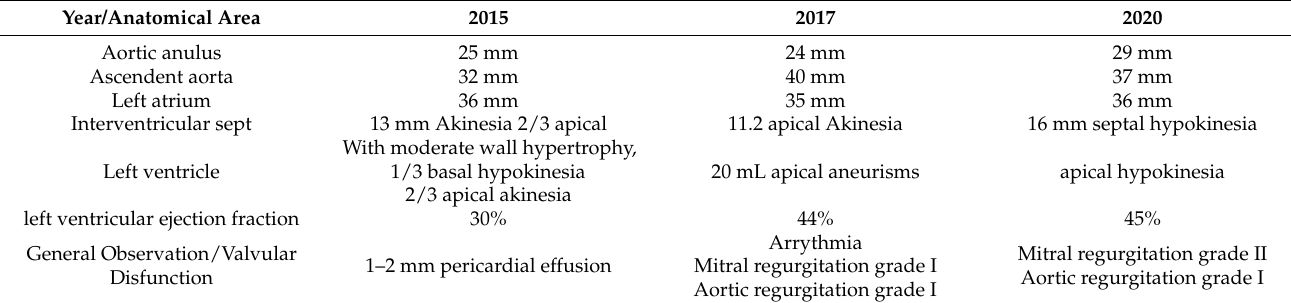
Figure 1. The EKG of the patient, recorded in 2015 at age 20, after consumption of AAS IV. Table 2. Echocardiographic evaluation: acute and follow up.